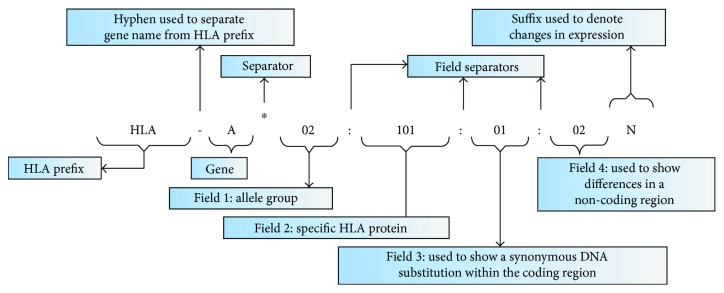
New HLA nomenclature patterns (adopted from [8, 20]).